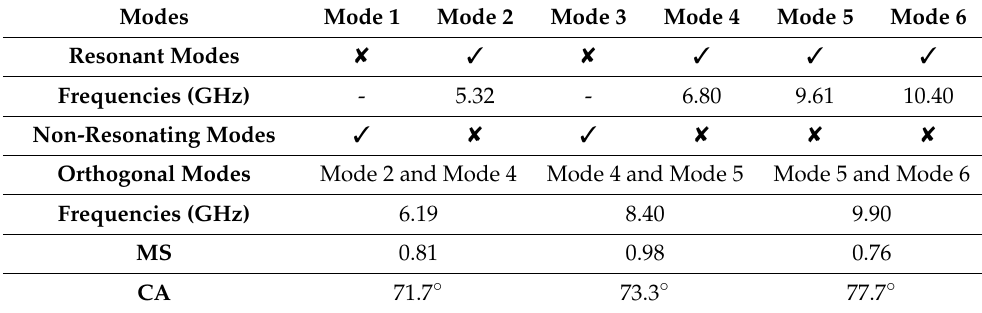
Table 2. CMA parameters of the proposed antenna.